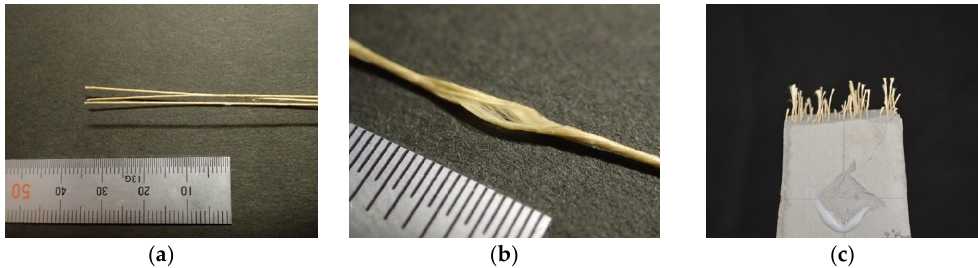
Figure 1. Aramid fiber used in this study: ( a ) Bundled fiber for pullout test; ( b ) Condition of bundling of yarns; ( c ) Example of chopped fiber in fiber-reinforced cementitious composite (FRCC).